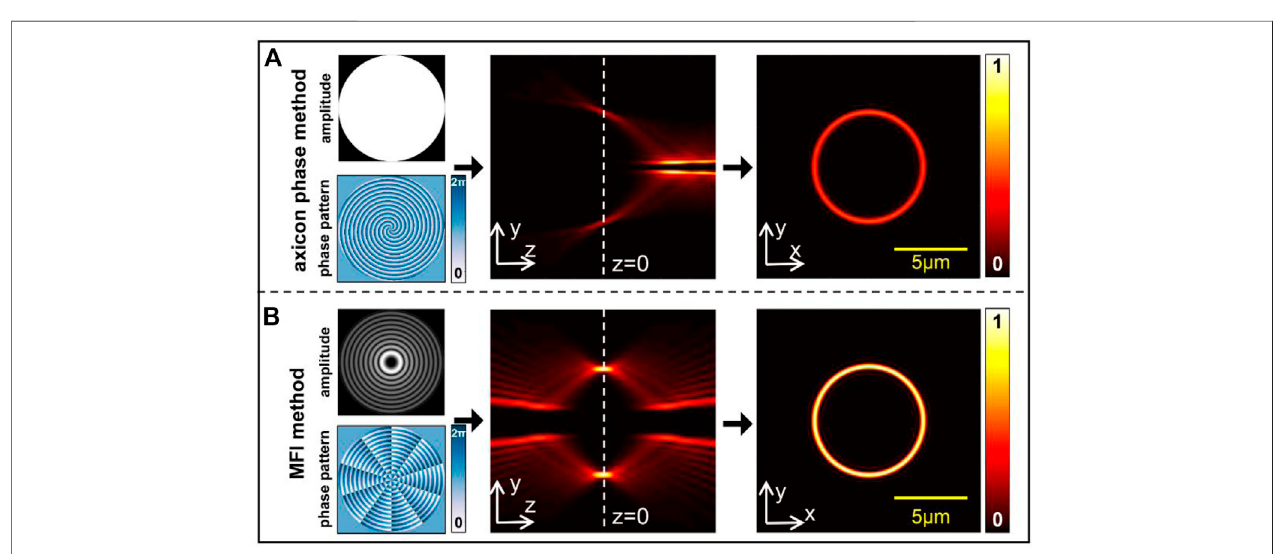
FIGURE 2 | Phase pattern, amplitude, and intensity distribution of generated POV by different methods. (A) Axicon phase method. (B) MFI method. Scale bar: 5 μ m.